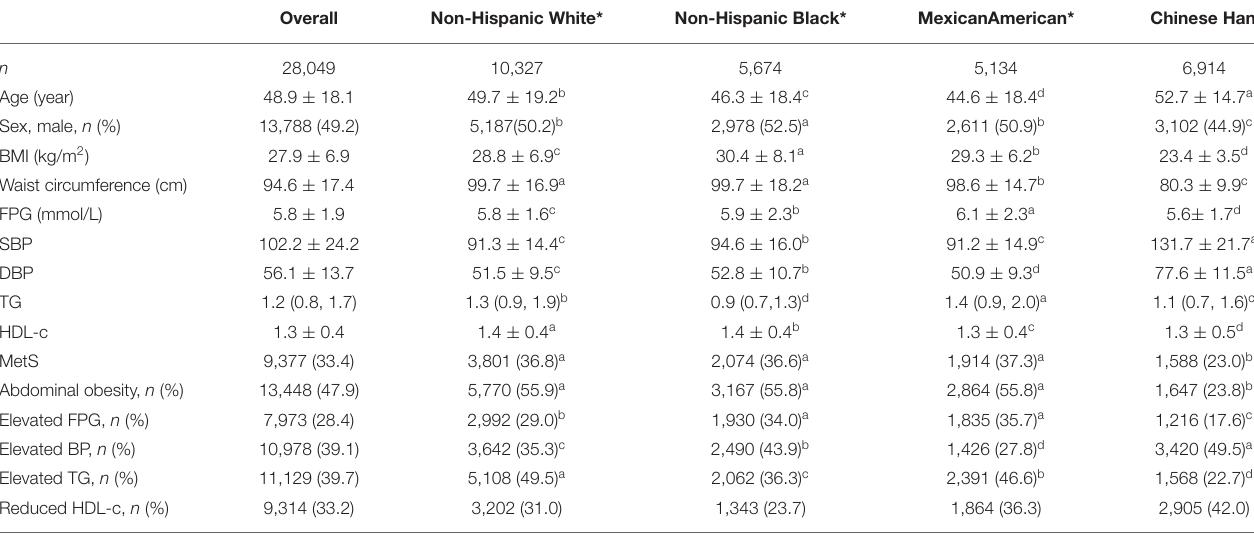
TABLE 1 | Characteristics of participants stratified by